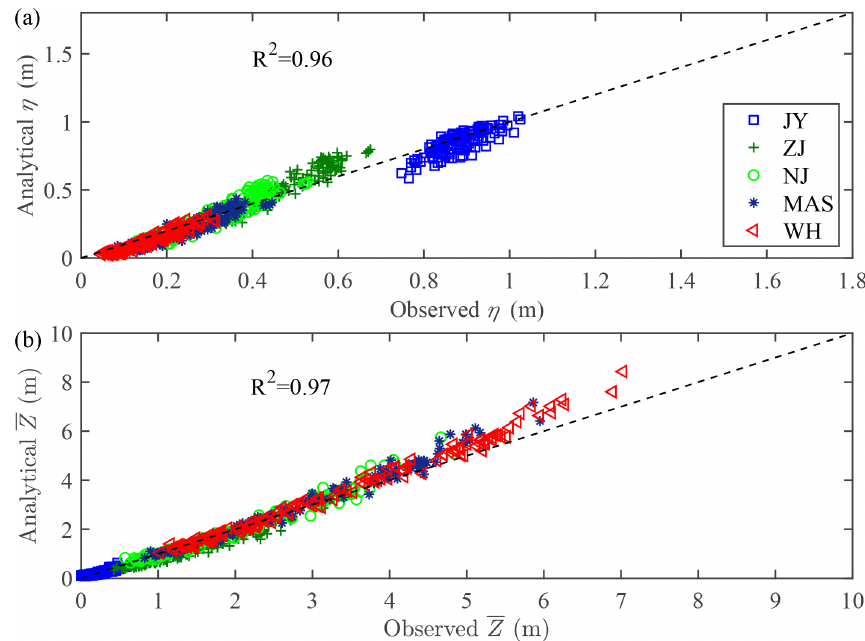
Figure 5. Comparison of analytically computed tidal amplitude, η , (a) and residual water level, Z , (b) against the observations in the Yangtze River estuary during the study period